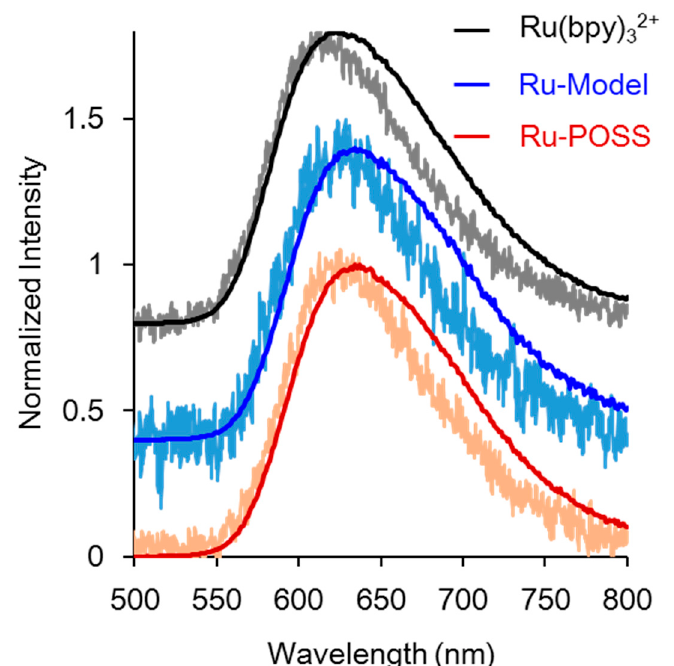
Figure 1. ECL (jagged line) and PL spectra (smooth line) of the Ru(II)-containing materials. The spectra of Ru(bpy) 32 + and Ru-Model are shifted in the y -axis direction for clarity. Table 1. Luminescent properties of the Ru(II)-containing materials a .